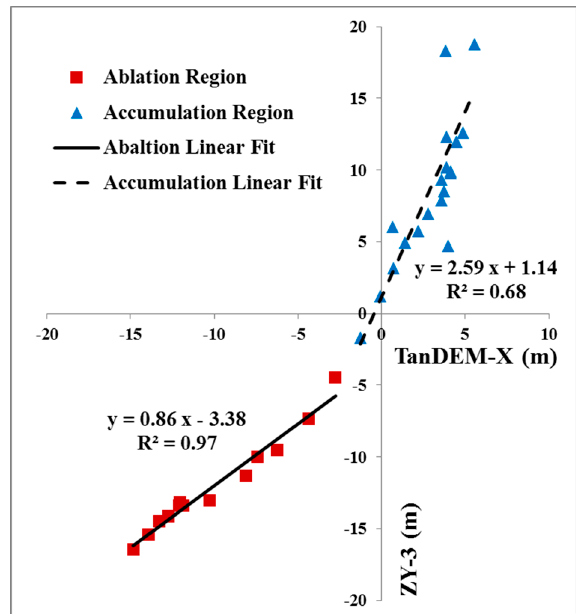
Figure 16. Glacier thickness changes in 50 m elevation bins from ZY-3 (02 / 2000–12 / 2013) against that from TanDEM-X (02 / 2000–03 / 2014) in the WNM.